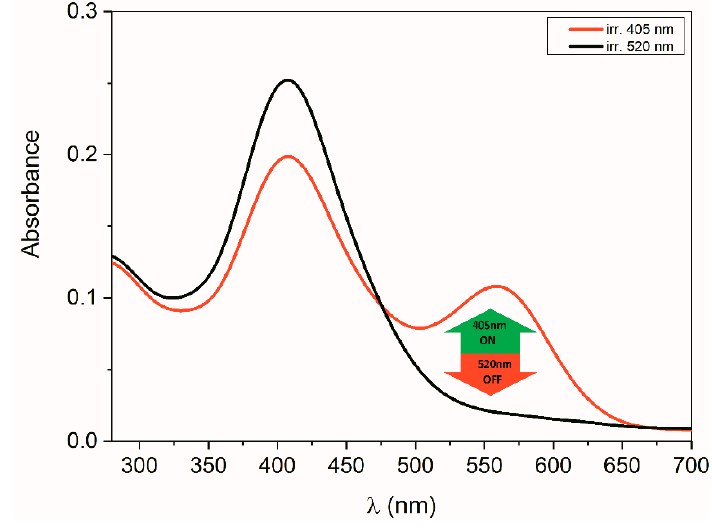
Figure 10. Photoswitching of anion of hydrazone 3 (1 × 10 − 5 mol·dm − 3 ) + TBAF (1 × 10 − 2 mol·dm − 3 ) in CHCl 3 .